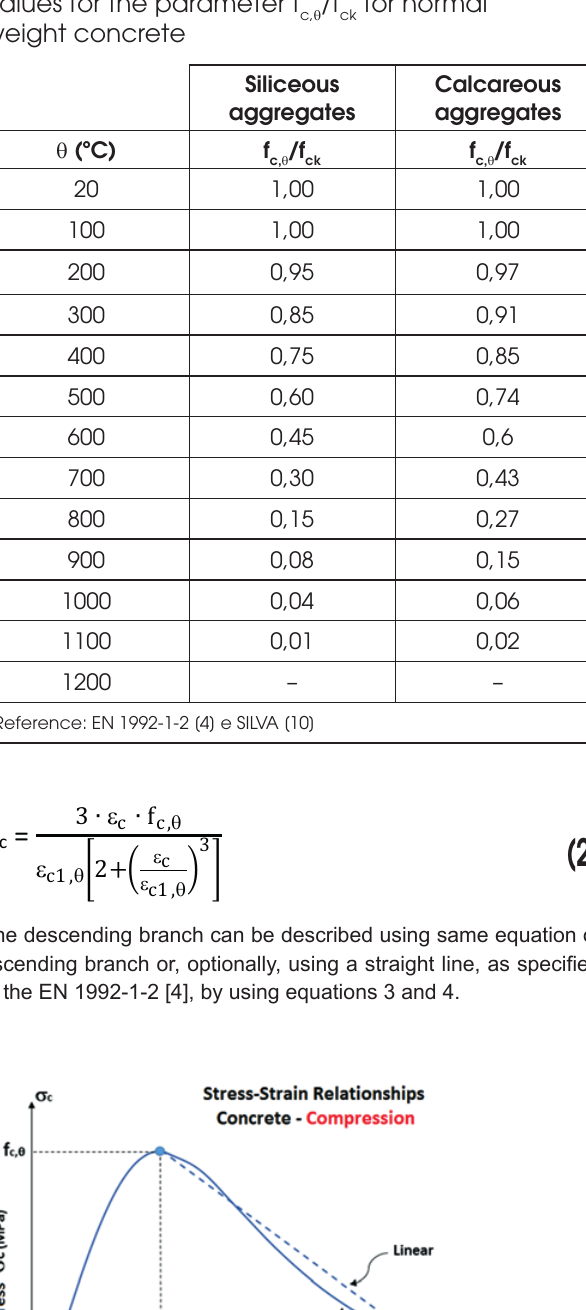
/f for normal c, θ ck